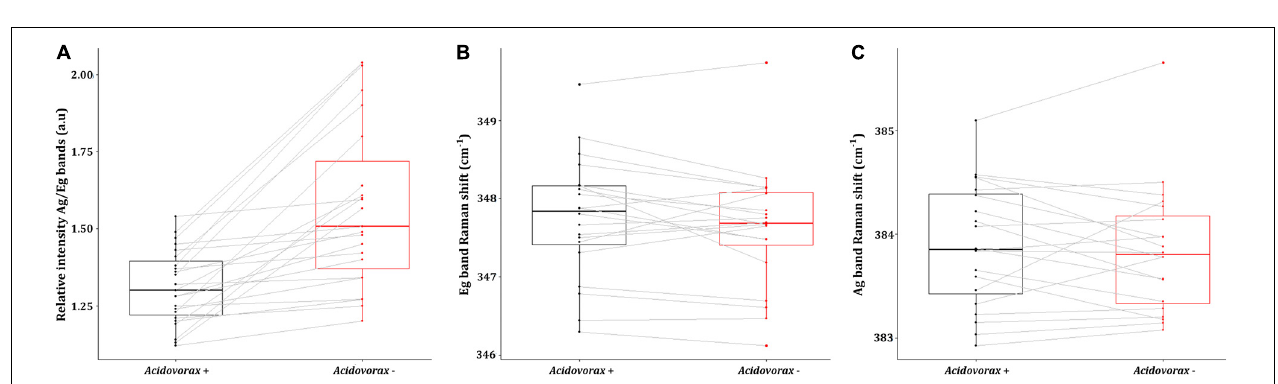
FIGURE 6 | Raman images of native samples from the IPB subsurface at –139.4 m (A–C) and –206.6 m (D–G) showing the co-localization of cells and pyrite areas with low intensity ratio of Ag band relative to Eg band. (A,E) Raman map of Acidovorax (green). (E) Raman map of exopolysaccharides (red), (B,E) Raman map colored according to the Ag/Eg ratio intensity of pyrite spectra. (C,G) merge. Scale bar, 1 µ m.